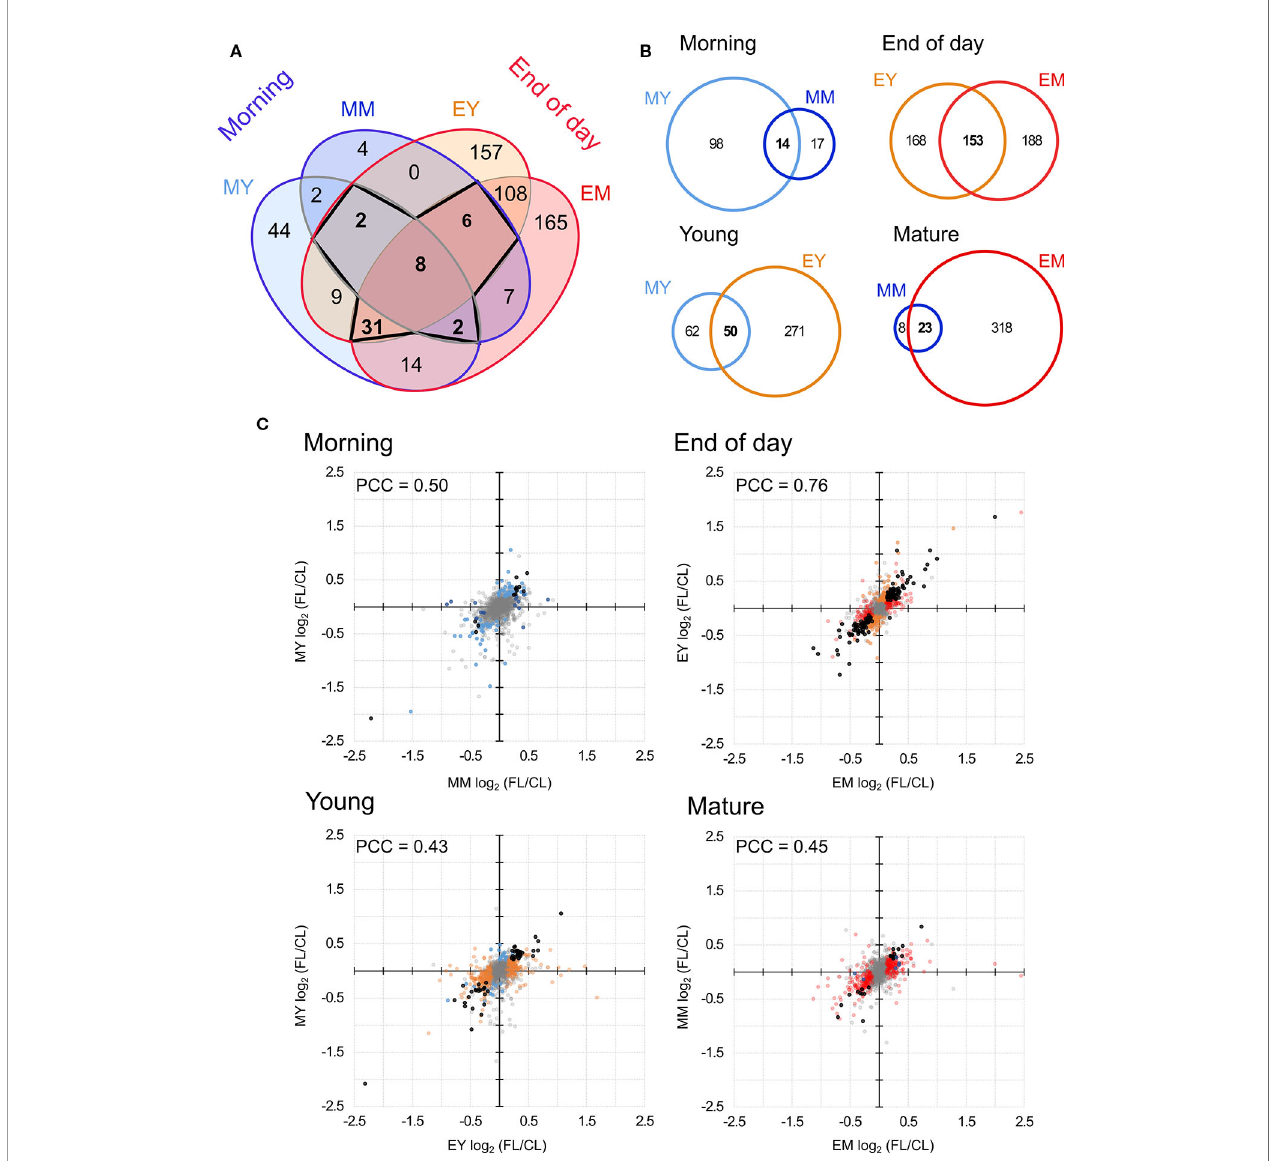
FIGURE 4 | Comparison of proteins with signi fi cant FL-induced changes in abundance in each sample. (A) Overlap of signi fi cant changes in abundance in morning and at the end of day in both young and mature leaves. Bold numbers indicate the 49 proteins signi fi cantly changed in four or three samples. (B) Pairwise overlap of signi fi cant changes in protein abundance in the morning, at the end of day, in young leaves and in mature leaved. (C) Correlation of protein abundance ratio FL/CL between different samples. Colors indicate the sample in which the protein ratio was found to be signi fi cantly altered light blue, MY; dark blue, MM; orange, EY; red, EM. Black dots indicates signi fi cant change in both samples (overlap of Venn diagrams) and grey indicates no signi fi cant change. PCC, Pearson correlation coef fi